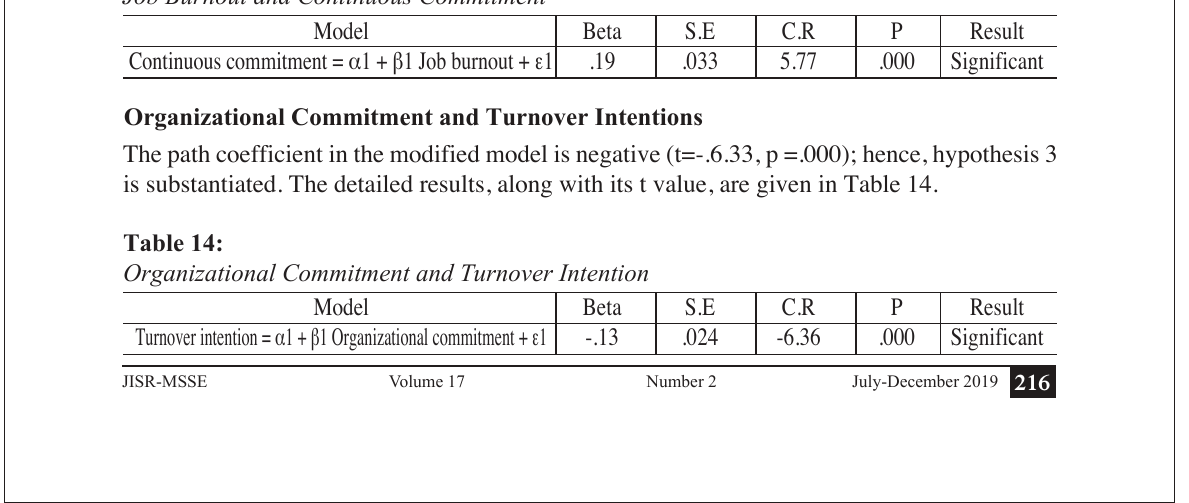
Job Burnout and Continuous Commitment